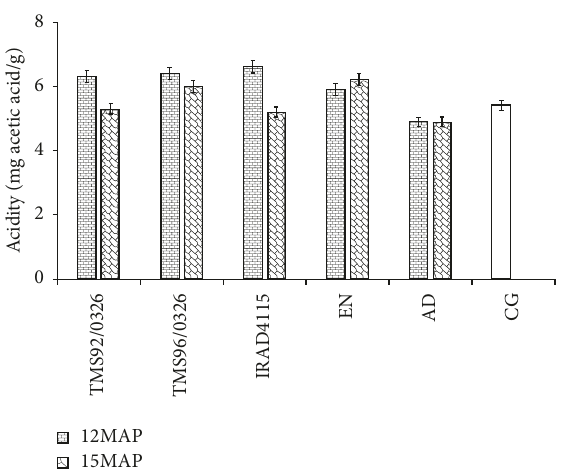
Figure 2: Influence of the harvest period (12 and 15 months after planting) on the titratable acidity (equivalent mg of acetic acid/g of dry weight) of cassava gari. Garis are produced from local ( EN and AD ) and improved ( TMS92/0326, TMS96/1414, and IRAD4115 ) cassava varieties harvested in dry season at 12 months and in rainy season at 15 months after planting (12MAP and 15MAP). These garis were compared to the commercial cassava gari (CG).